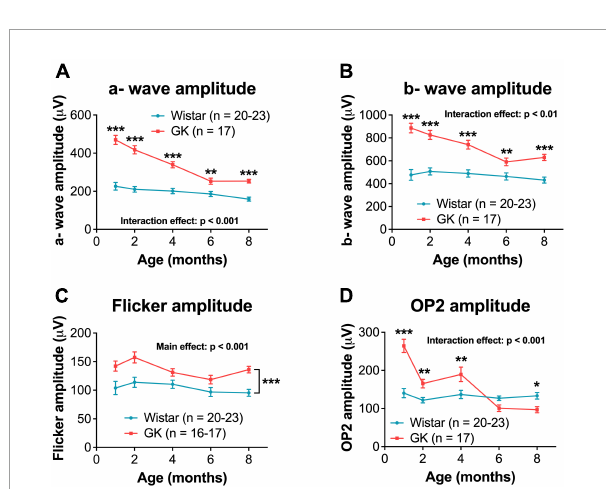
FIGURE4 Goto-Kakizaki rats showed greater dark-adapted ERG amplitudes that declined over time. Quantification of dark-adapted a- wave (A) , b- wave (B) , flicker (C) , and OP2 (D) amplitudes at 1, 2, 4, 6, and 8 months of age. A- wave, b- wave, and OP data shown was captured at a bright flash intensity, 0.7 log cd s/m 2 . Black asterisks indicate comparisons between GK and Wistar groups. For flicker amplitude, a main effect of group was observed. Asterisks are not included at individual timepoints because the significant difference is between GK and Wistar animals across all timepoints combined. * p < 0.05, ** p < 0.01, *** p < 0.001. Results expressed as mean ±